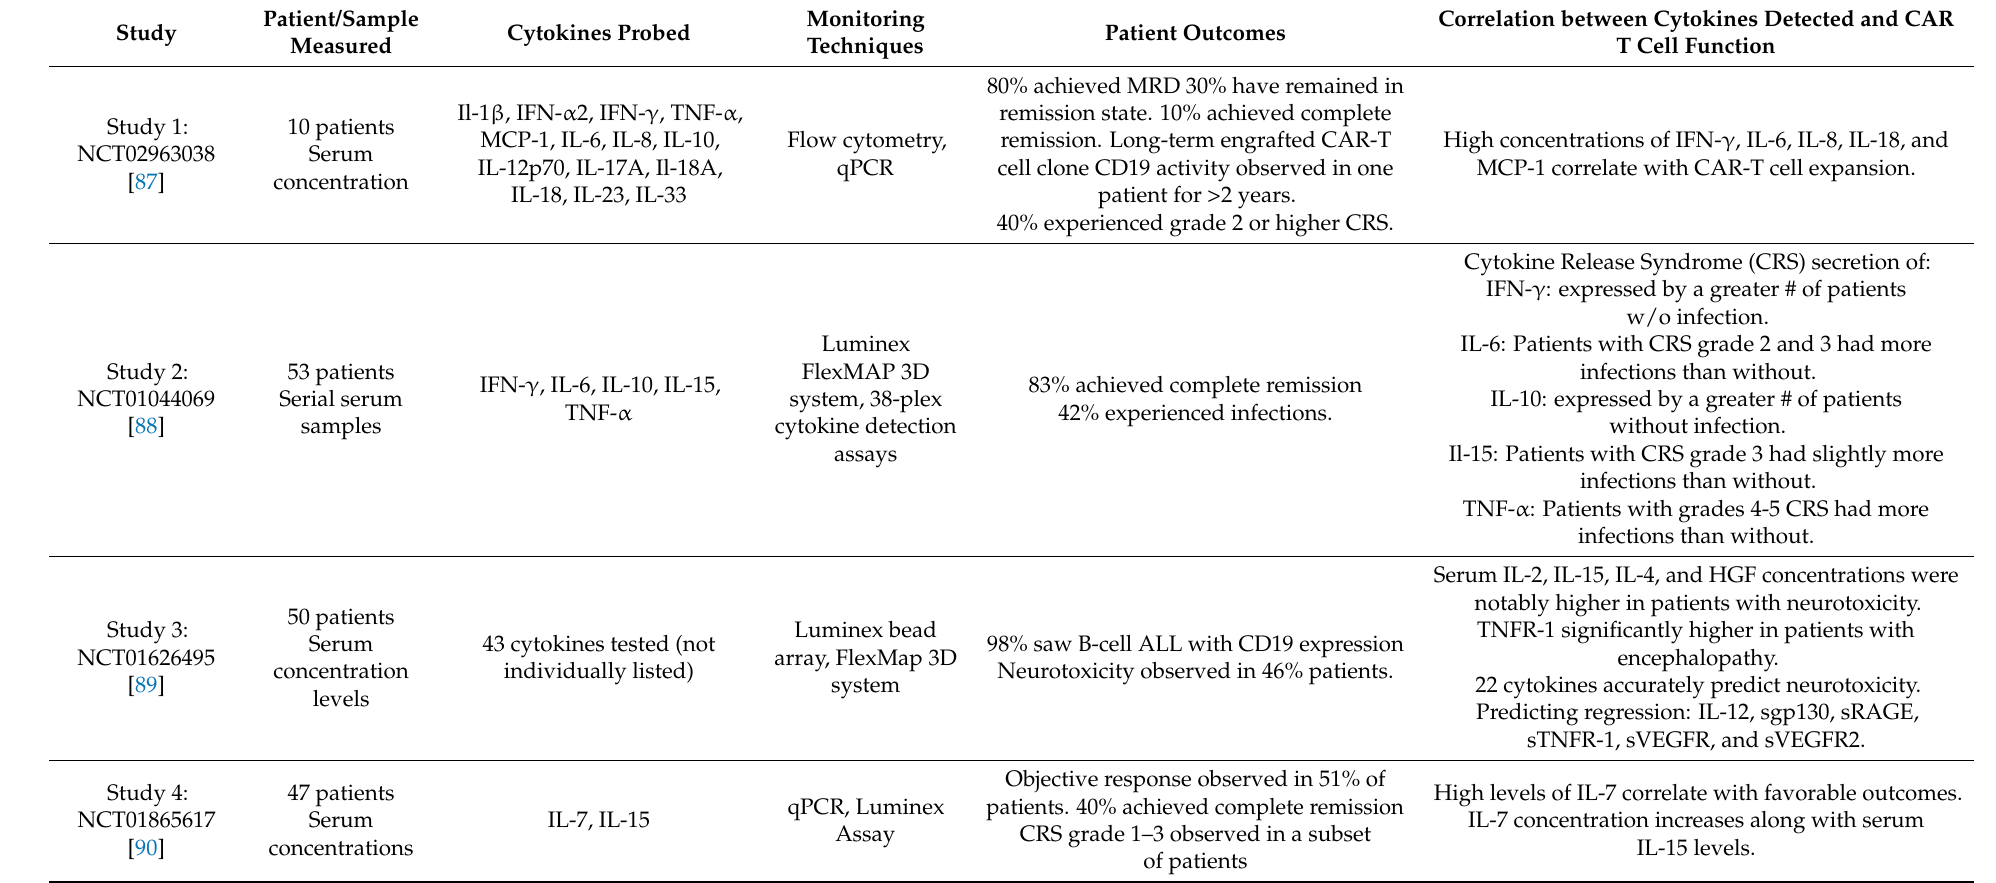
Table 2. Correlation between cytokine detection and treatment outcomes in clinical trials using CD19- targeted CAR-modified T cells.